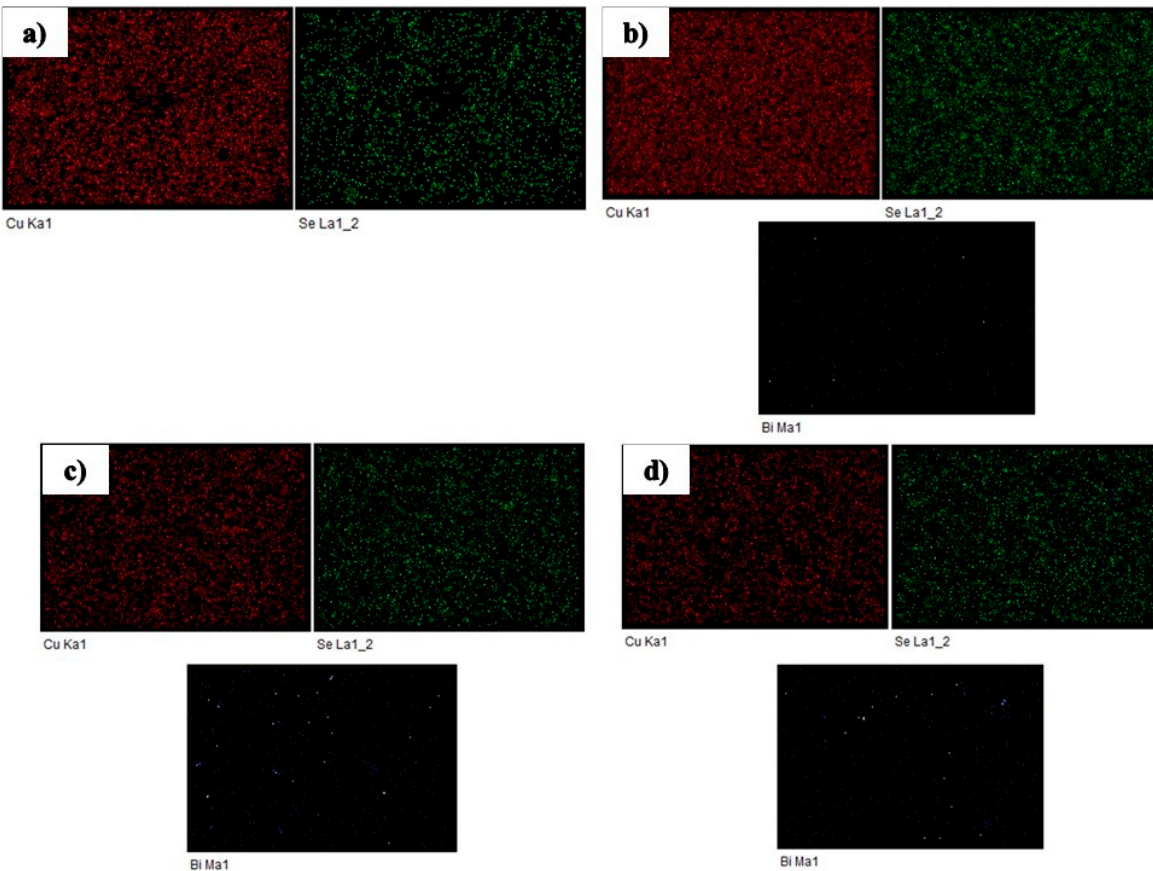
Figure 6. EDS map of ( a ) Cu 2 Se, ( b ) Cu 1.996 Bi 0.004 Se, ( c ) Cu 1.992 Bi 0.008 Se, ( d ) Cu 1.988 Bi 0.012 Se.